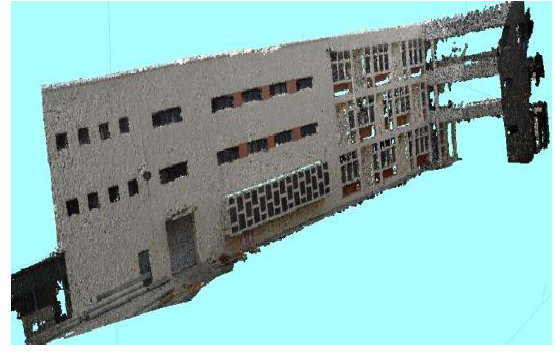
Figure 7: Dense point cloud